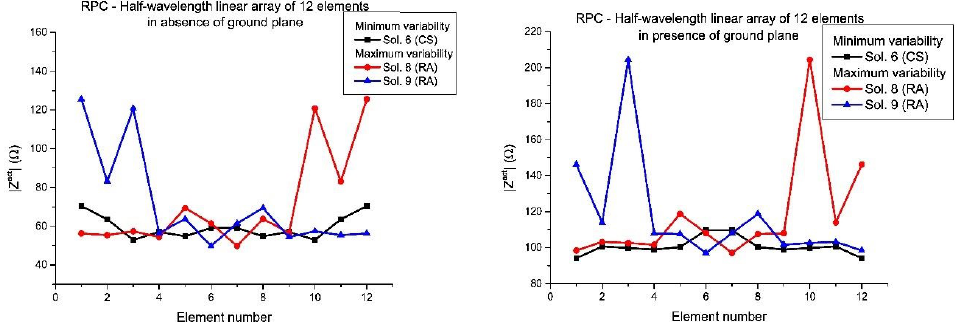
Figure 7. Detailed view of the active impedances which present the maximum and the minimum variability from the set of solutions for the RPC, in the case of the half-wavelength elements linear array of 12 elements: in absence of ground plane ( left ) and in presence of ground plane ( right ). The numbering of the solution agrees with Figure 1.